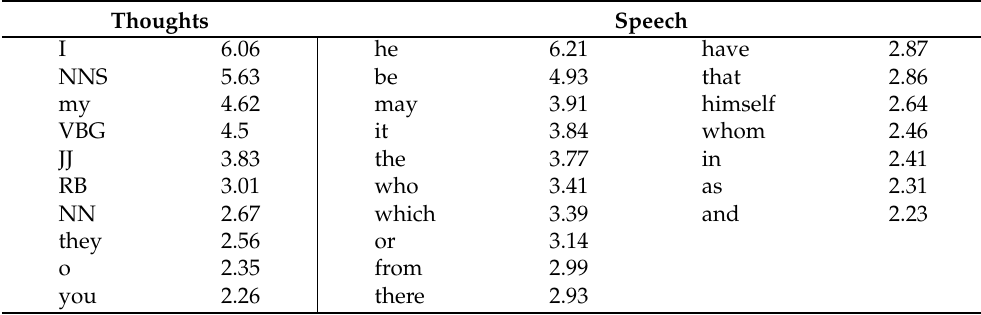
Table 2. Adjusted Pearson residuals for structural markers in Stephen’s thoughts and